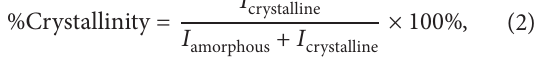
Figure 3: Simulated and experimental X-ray diffraction patterns revealingsimilarXRDpeakpatternsforthemodifiedcellulosewhen compared to its mixed CI 𝛼 and CI 𝛽 and CII